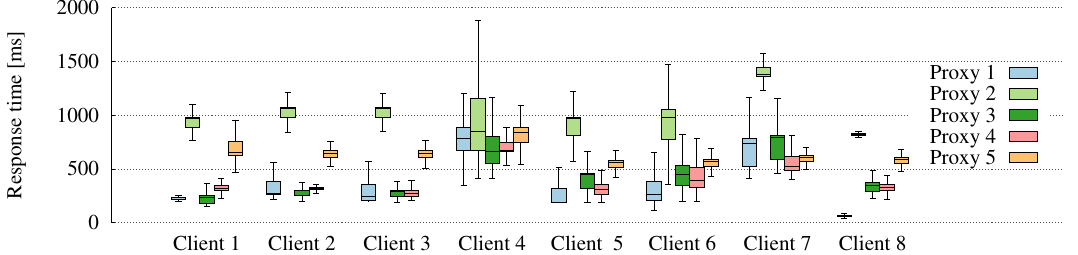
Figure 2. Boxplots describing the distribution of response time measurements collected for each client/proxy